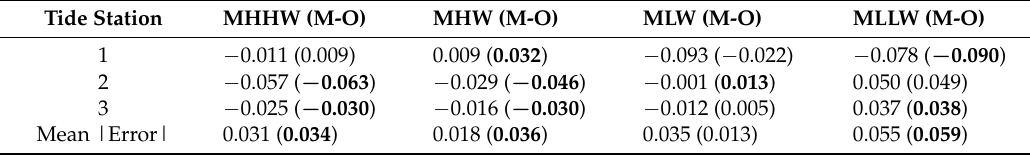
Table 2. The statistical values of the model errors from the current and previous tidal models (in meters). Tide Station MHHW